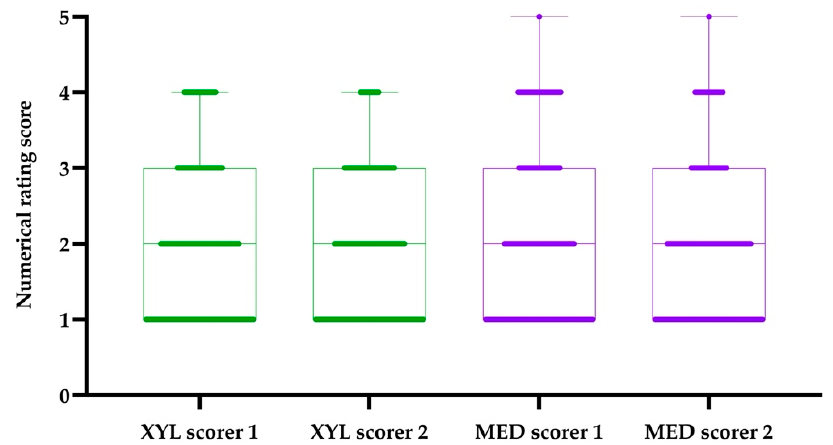
Figure 2. Distribution of recovery scores attributed by two independent and blinded observers (scorer 1 and scorer 2) on the basis of video recordings using a numerical rating score (1–5; 1 = smooth recovery in one attempt, 5 = recovery resulting in injury) for recoveries following xylazine partial intravenous anaesthesia (PVIA) (XYL, green) or medetomidine PIVA (MED, purple) with isoflurane. The bold horizontal lines represent the frequency of scores for each scorer and each group; the boxes imply the median, 5th–95th percentiles, and range of scores.